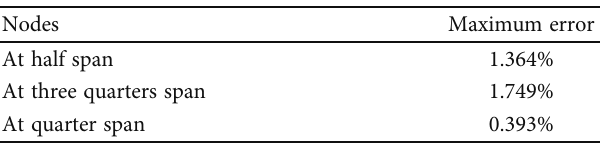
Figure 12: The interpolation of the vibration shapes based on RBF method: (a) the fi rst-order interpolation; (b) the second-order interpolation; (c) the third-order interpolation; (d) the fourth-order interpolation. Table 3: Relative errors of interpolation displacements based on IIM and RBF